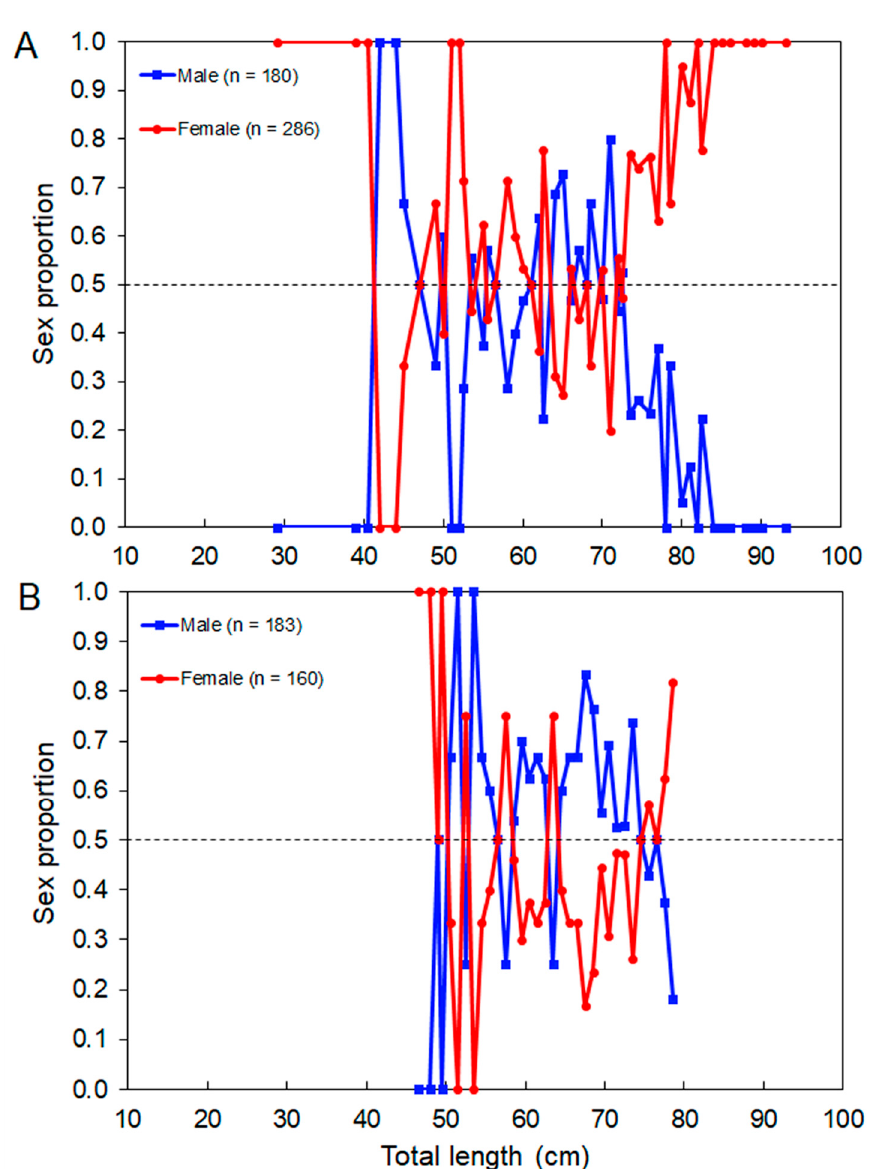
Figure 7. Sex proportion of the thornback ray Raja clavata by total length ( L T )–class derived from the ( A ) scientific surveys and ( B ) commercial catches in the Azores. The number of individuals (n) refers to the total number of sampled thornback rays. The dashed line shows an equal sex ratio.